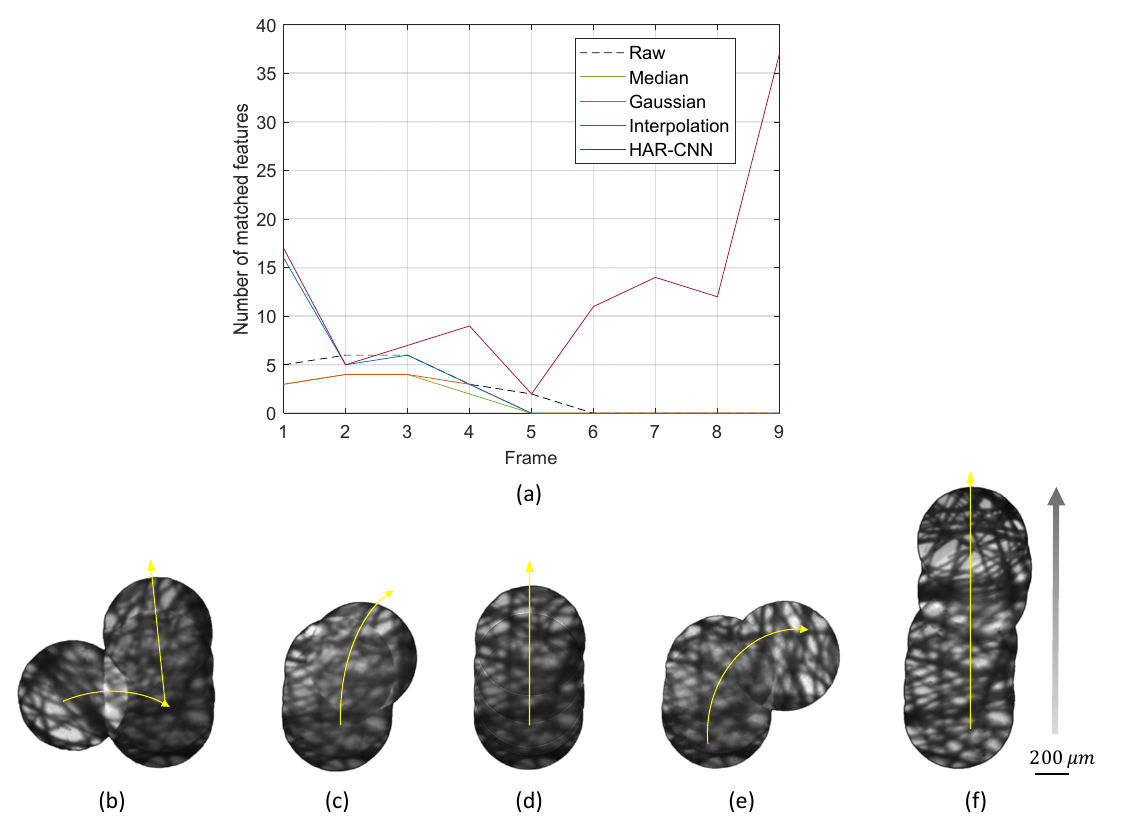
Figure 9. ( a ) The number of matched image features between successive frames for various honey- comb removal methods. ( b – f ) Mosaic images during a handheld scan of the fiber bundle probe on the lens tissue sample: ( b ) by use of raw images, ( c ) median filter, ( d ) Gaussian filter, ( e ) interpolation, and ( f ) HAR-CNN for honeycomb pattern